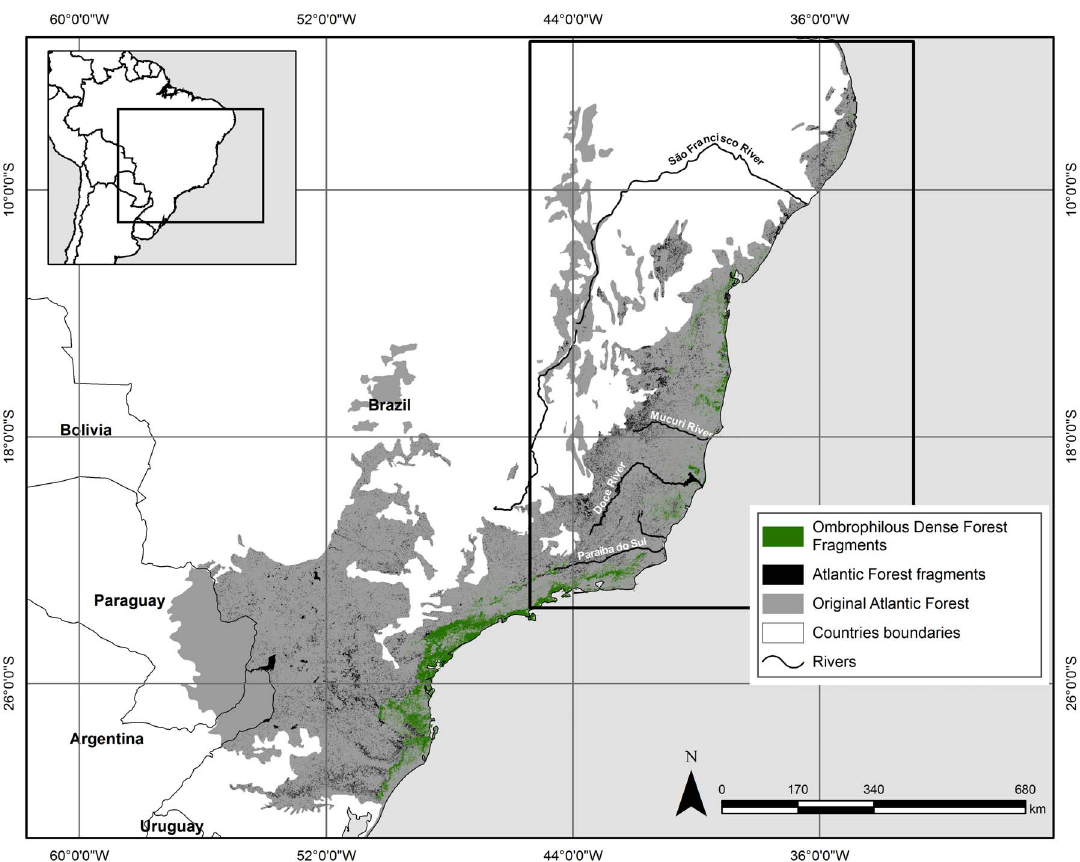
Figure 1. Original and current extent of the Atlantic Forest region in Brazil. The black box corresponds to the extent of the maned sloth’s extent. Cartographic bases: [32,57,58,79]. Geographic Projection: Datum WGS 1984.